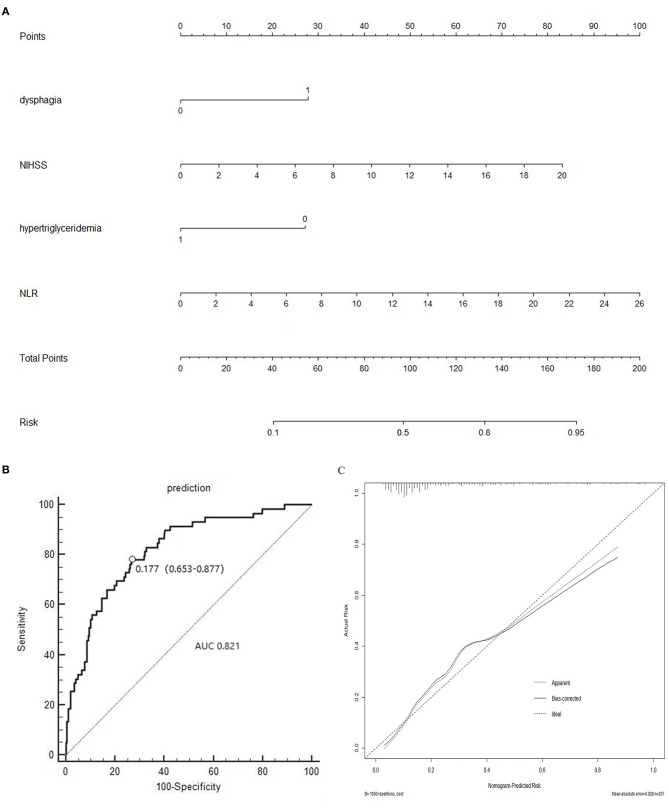
(A) Nomogram of the study population to predict SAI in patients after stroke; (B) Area under the receiver operating characteristic curve (AUROC), which is representative of predictive accuracy. The c-index value for the nomogram is 0.821 ± 0.03. (C) Calibration curve for the nomogram.